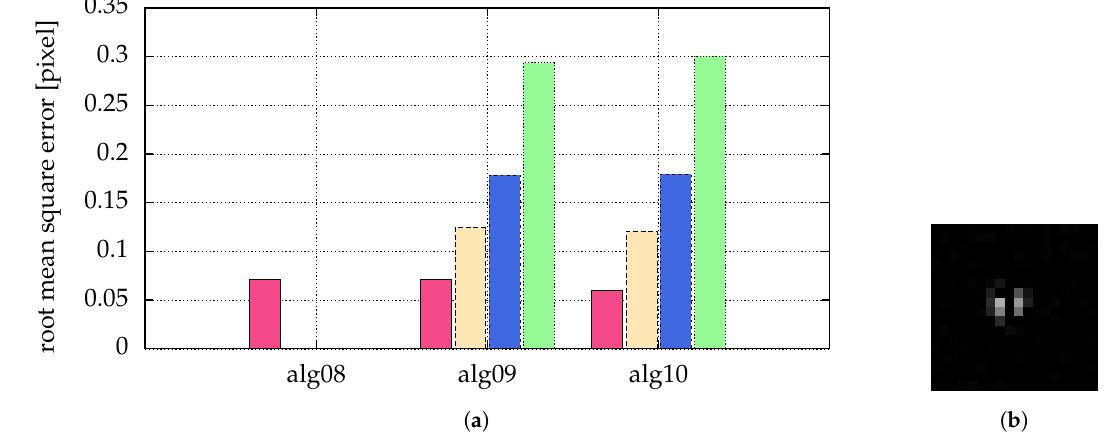
Figure 11. ( a ) Comparison of different strength of pepper noise: pink ( (cid:4) ) bars for a probability of pepper noise of 1 %, yellow ( (cid:4) ) for 5 %, blue ( (cid:4) ) for 10 % and green ( (cid:4) ) for 20 %. Missing bars imply that not all particles where correctly detected. The ordinate shows the root mean square error of the distance between detected and real positions. The Gaussian noise was combined with a SNR = 100. The statistics/simulation was done with images containing 10,000 particles with σ { x , y } = 1. ( b ) The right image shows a single particle separated by pepper noise with a probability of 20